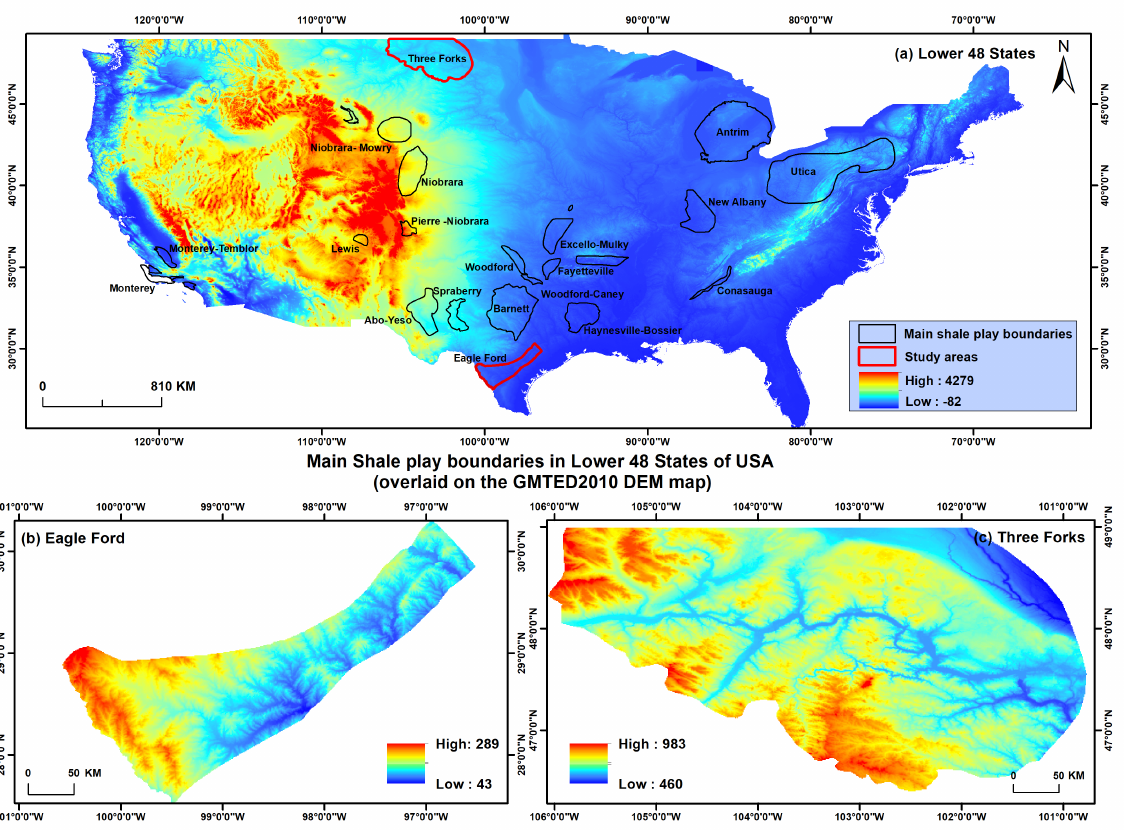
Figure 1. The distributions of main shale gas plays in 48 states of the United States, and the locations of Eagle Ford and Three Forks in the United